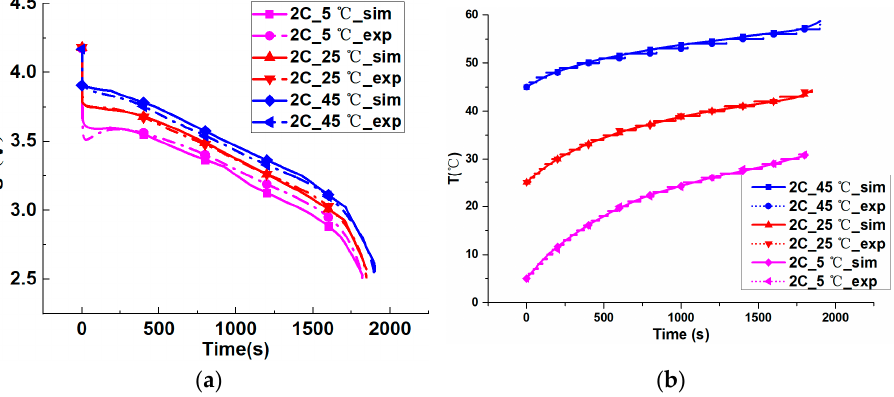
Figure 7. ( a ) Experimental and model output voltages at di ff erent ambient temperatures; ( b ) Internal temperature of experimental and model ba tt eries at di ff erent ambient temperatures.